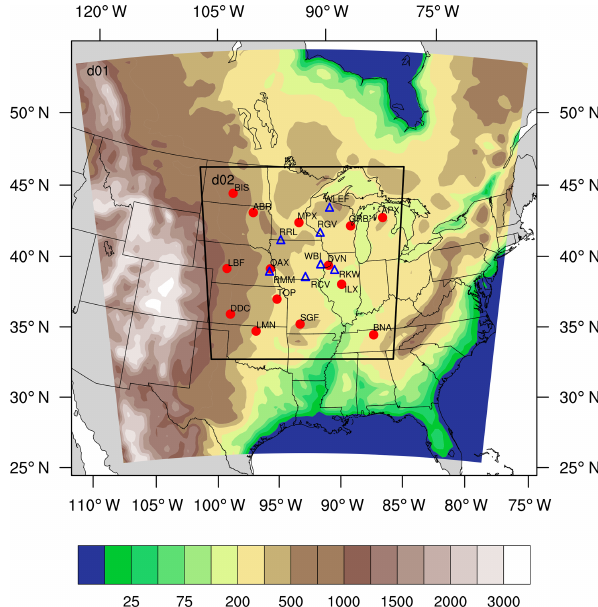
Figure 1. Geographical domain used by WRF-ChemCO 2 physics ensemble. The parent domain (d01) has a 30km resolution, the in- ner domain (d02) has a 10km resolution. Contours represent terrain height in meters. The inner domain covers the study region and in- cludes the rawinsonde sites (red circles) and the CO 2 towers (blue triangles)